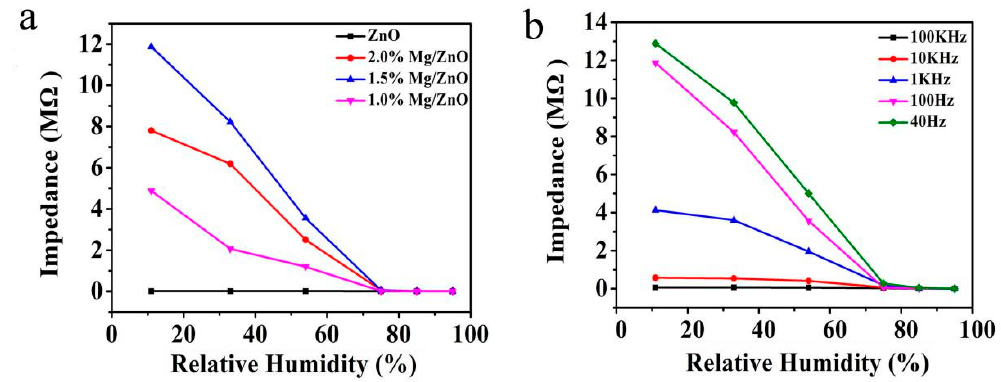
Figure 6. ( a ) Impedance versus RH curves of a Mg-doped ZnO humidity sensor with different ratios, ( b ) relationship of impedance and RH about Mg-doped ZnO (1.5 mol%) microspheres at various frequencies.